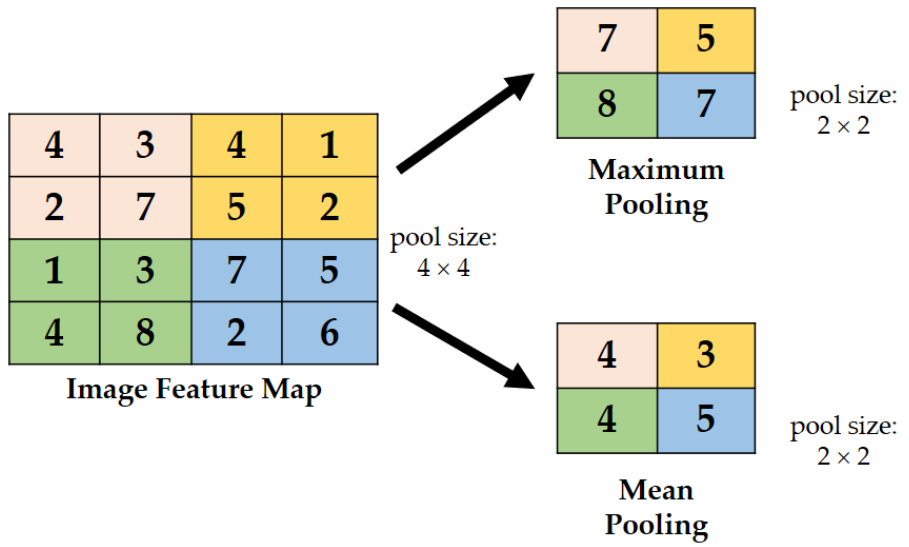
Figure 10. Illustration of max–min pooling.